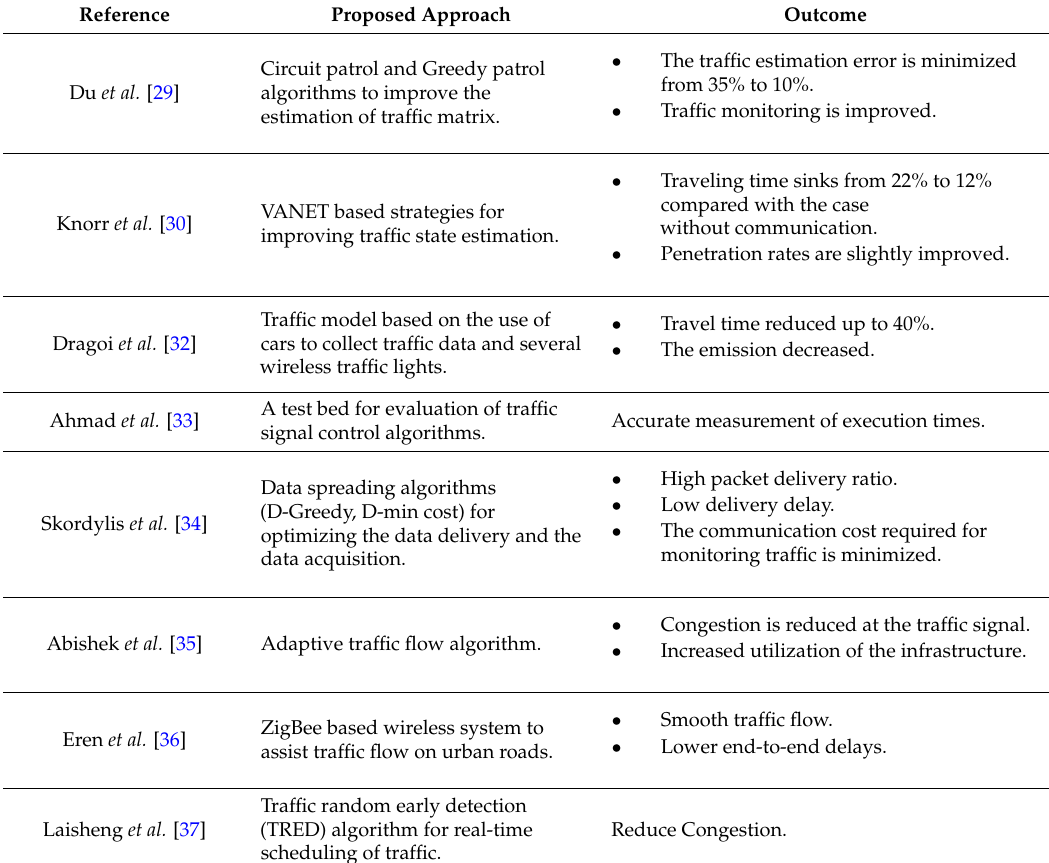
Table 6. Summary of congestion avoidance